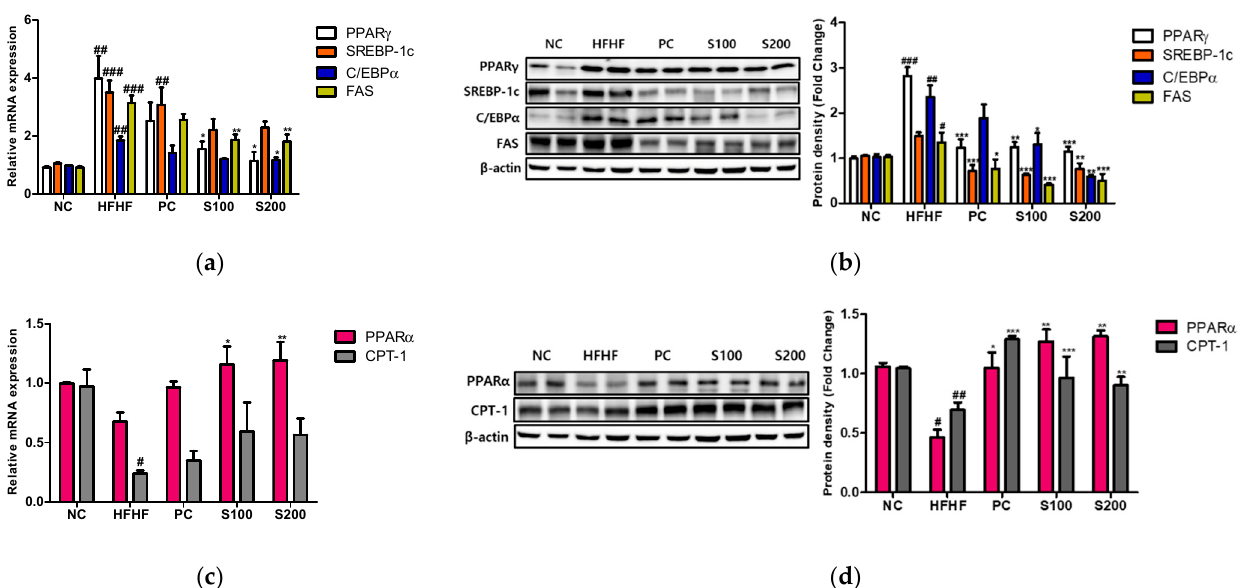
Figure 6. Effects of Bombyx mori (SW) on the expression of genes associated with lipogenesis and fatty acid oxidation in HFHF-fed mice. ( a ) Quantitative real-time PCR analysis of PPAR γ , SREBP-1c, C/EBP α , and FAS were normalized by β -actin as an internal control. ( b ) Expression of lipogenesis-related proteins, including PPAR γ , SREBP-1c, C/EBP α , and FAS. Equal loading of protein was verified by β -actin. ( c ) The mRNA expression of PPAR α and CPT-1 were quantified by real-time PCR and normalized by β -actin as an internal control. ( d ) Quantification of the protein levels of PPAR α and CPT-1. NC, normal control; HFHF, 45% high fat diet with 10% fructose in the drinking water; PC, positive control (HFHF diet with 1% silymarin); S100, HFHF diet with SW (100 mg/kg/day); S200, HFHF diet with SW (200 mg/kg/day). PPAR γ , peroxisome proliferator-activated receptor-gamma; SREBP-1c, sterol regulatory element-binding protein 1-c; C/EBP α , CCAAT/enhancer-binding protein alpha; FAS, fatty acid synthase; PPAR α , peroxisome proliferator-activated receptor-alpha; CPT-1, carnitine palmitoyltransferase 1. The results from three independent experiments are expressed as the means ± SE. # p < 0.05, ## p < 0.01, and ### p < 0.001 vs. NC; * p < 0.05, ** p < 0.01, and *** p < 0.001 vs. HFHF.